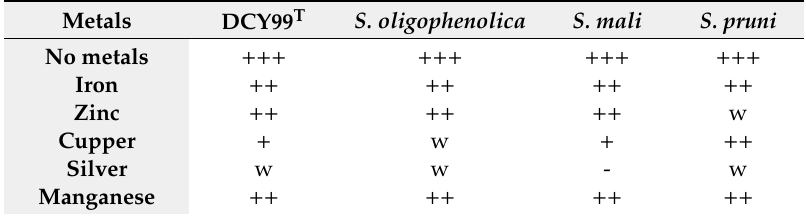
Table 2. Metal tolerance of four Sphingomonas